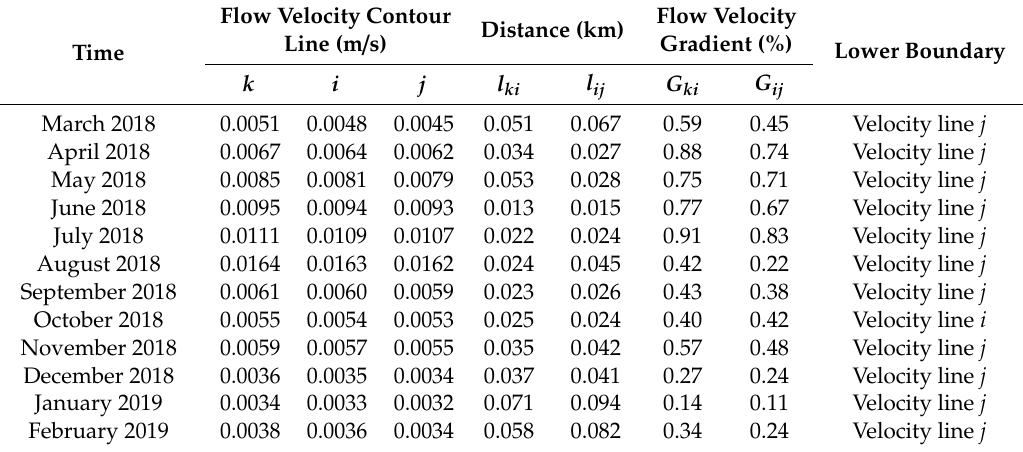
Table 3. Calculation of the flow velocity gradients G ij and G ki in the Baigou Canal–Baiyangdian Lake transition zone. Figure 5 shows the positions of lines k , i , and j . Flow Velocity Contour Line (m / Time